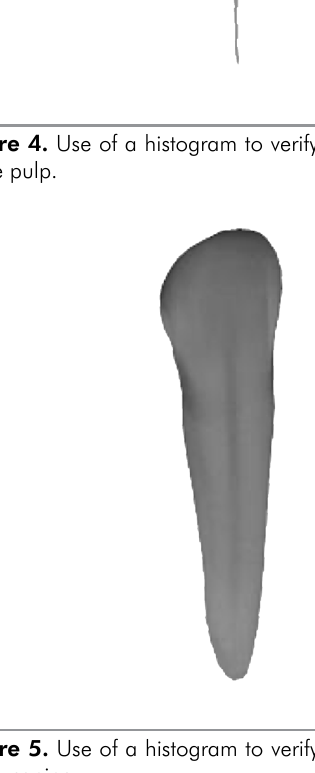
Figure 3. Outline of the canine tooth.